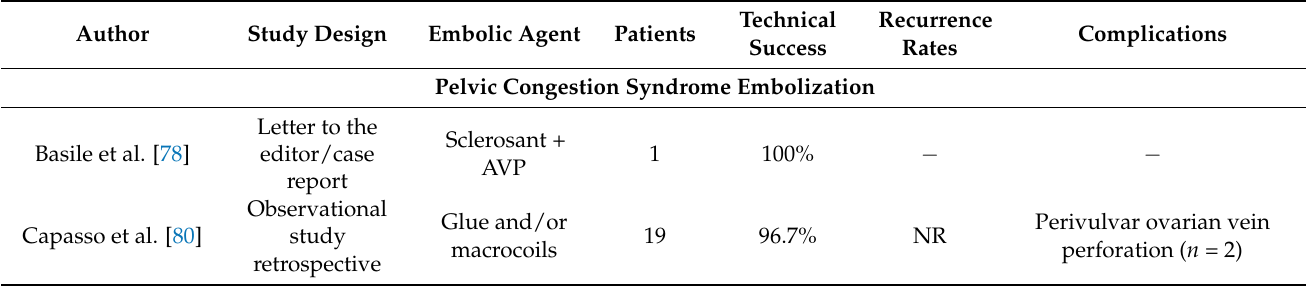
Table 3. This table summarizes the publications taken into consideration, the embolic materials used, the technical success rate, the recurrence rate and complications for male pelvic congestion